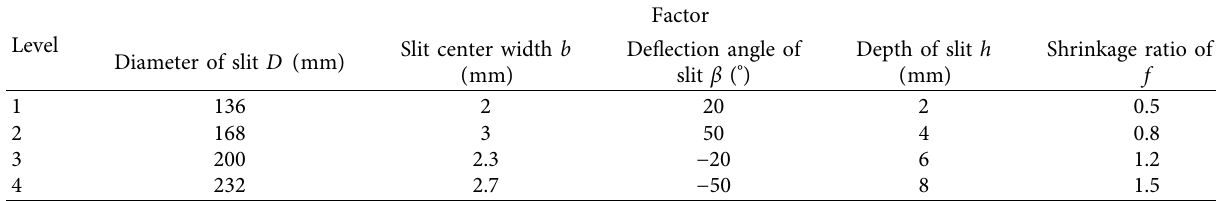
Figure 8: Slit geometry parameters. Table 4: Factor and level table.